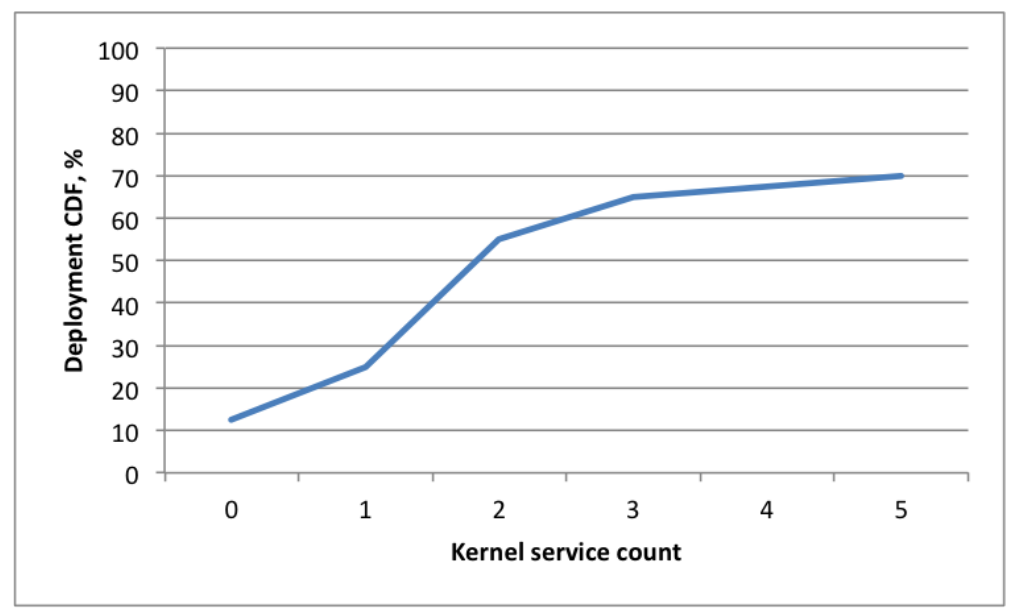
Figure 10. The number of kernel level software services used in deployments —fifty-five percent of deployments use two or less kernel services. For 28%, the kernel service count is unknown.